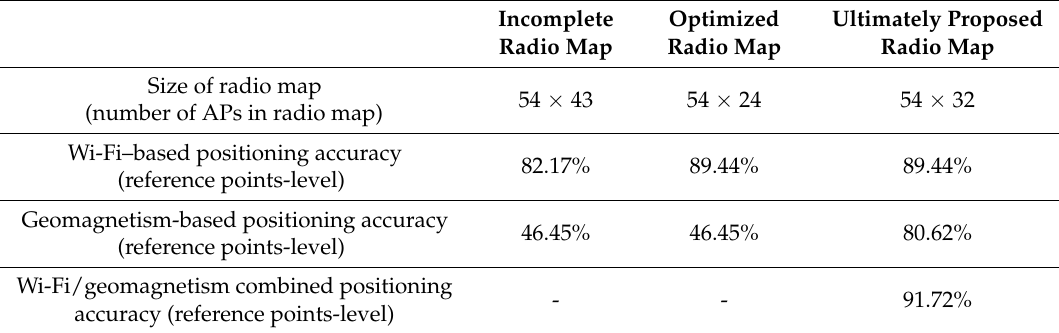
Figure 9. Positioning accuracy according to the number of geomagnetic sensor updates. Table 2. Changes in radio-map dimensions and positioning accuracy according to the proposed positioning